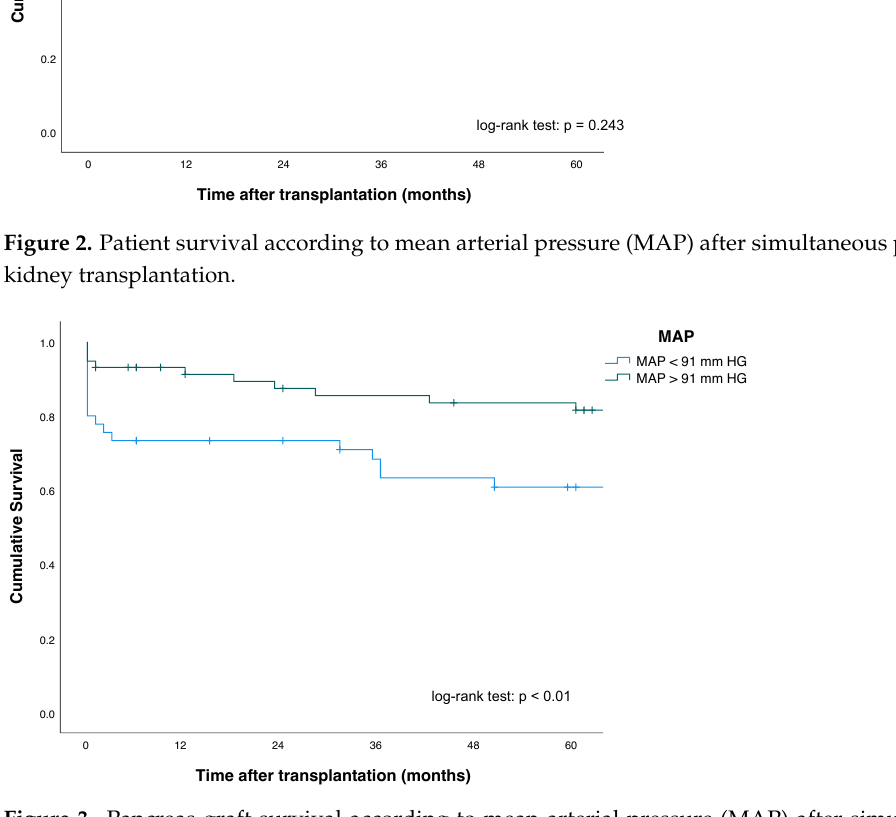
Figure 3. Pancreas graft survival according to mean arterial pressure (MAP) after simultaneous pancreas–kidney transplantation.